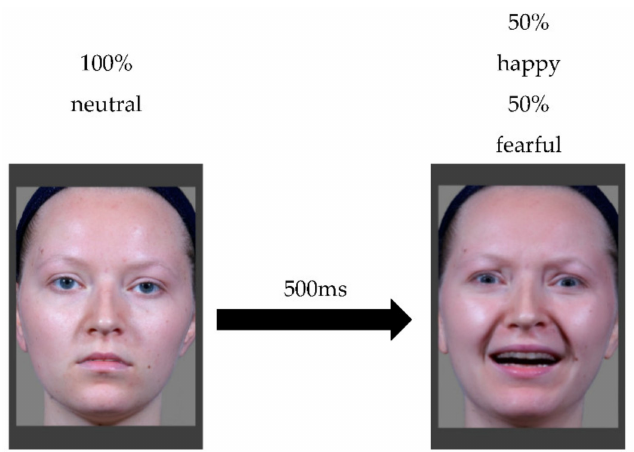
Figure 2. Example of a dynamic morphed stimulus animation. When appearing on the presentation screen, each stimulus had a height of 16.8 cm and a width of 11.4 cm with a resolution of 412 × 604 pixels (see Figure 3).